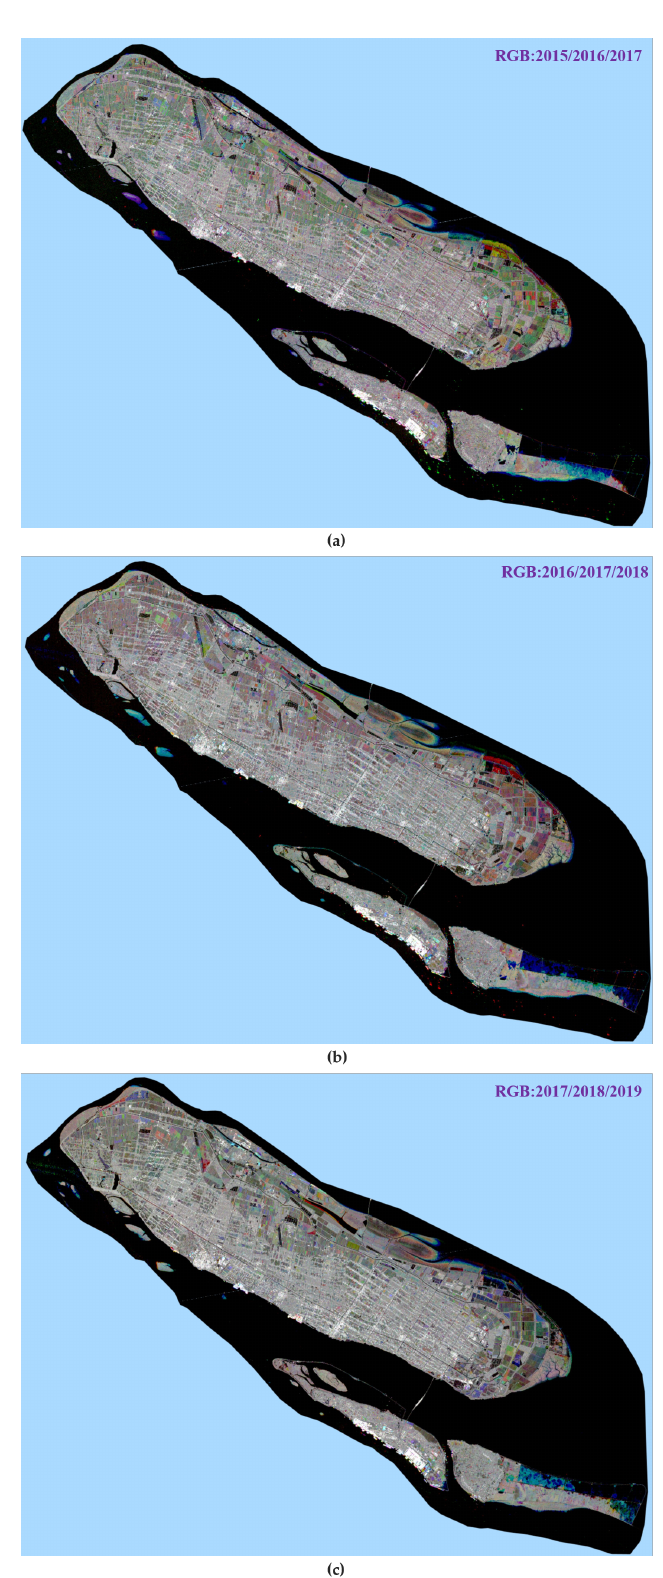
Figure 7. VH multi-temporal surface reflectance composites for Chongming island. RGB:2015/2016/ 2017 denotes the combinations of VH image bands from 2015 to 2017. Specifically, 2015, 2016, and 2017 represent the channels of R, G, and B,